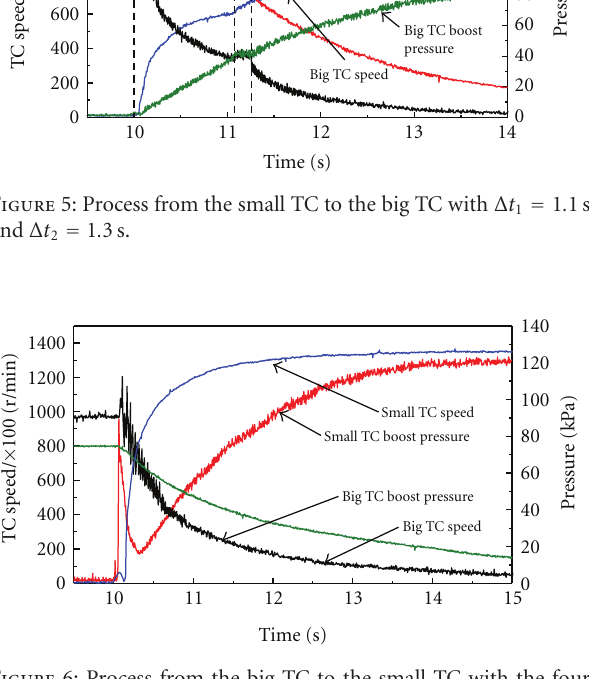
Figure 6: Process from the big TC to the small TC with the four valves activated synchronously.